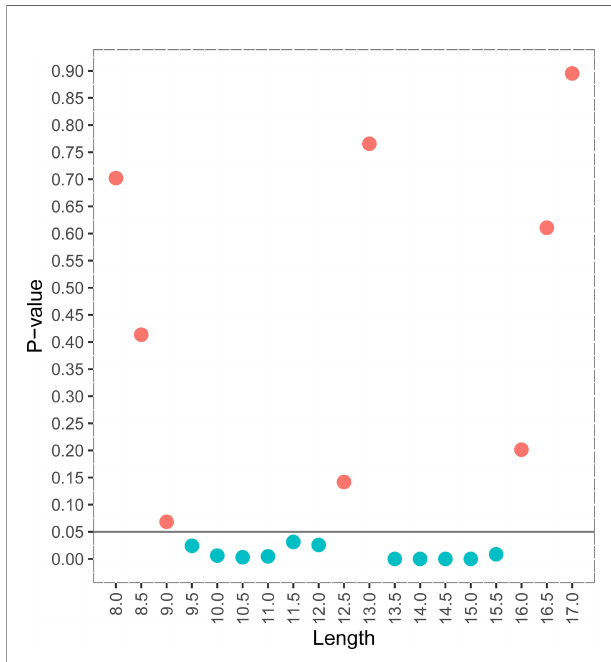
FIGURE 3 | p-values of the hypothesis test that the probability of catch at each length between research catch and commercial catch vessels is equal (red dot, not signi fi cant; light blue dot, signi fi